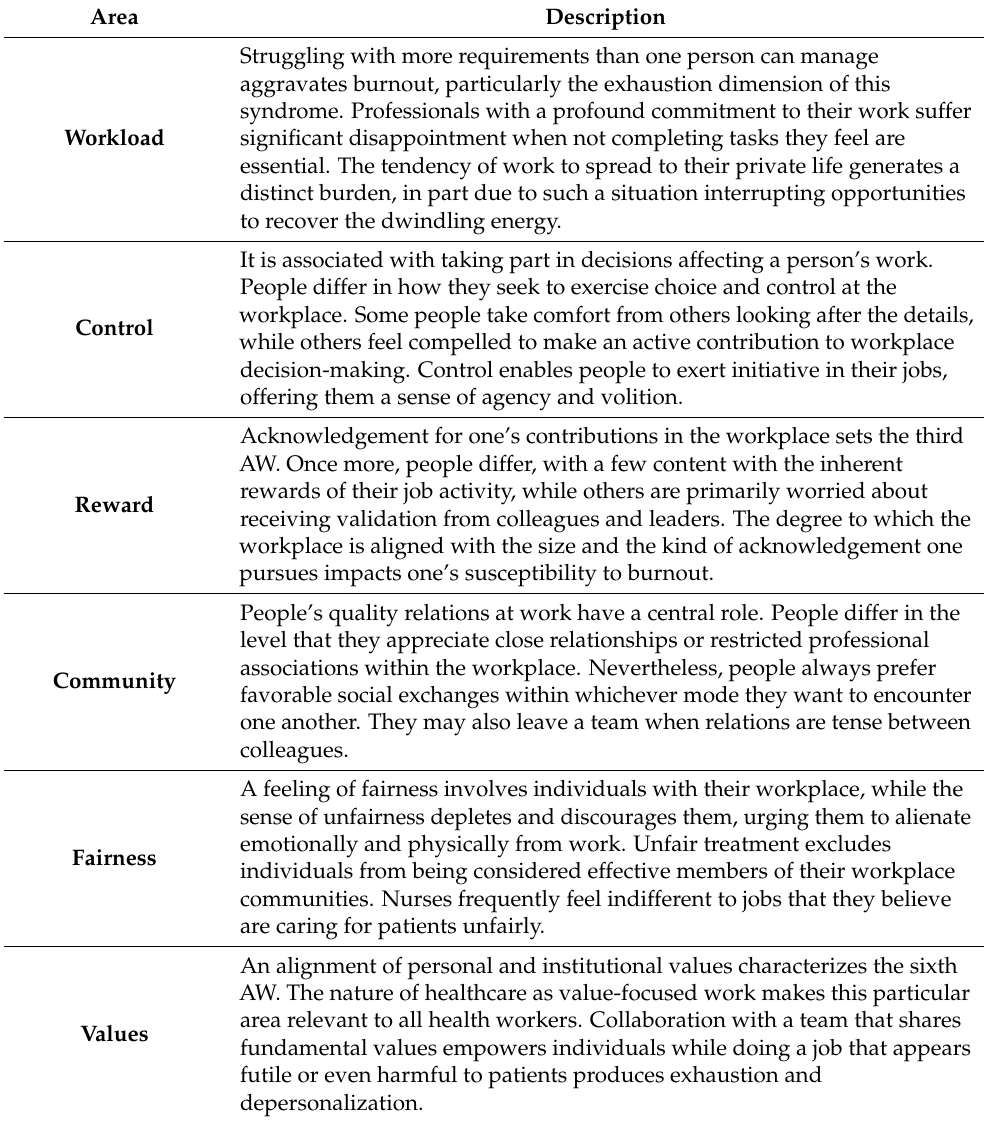
Table 2. Description of the AW